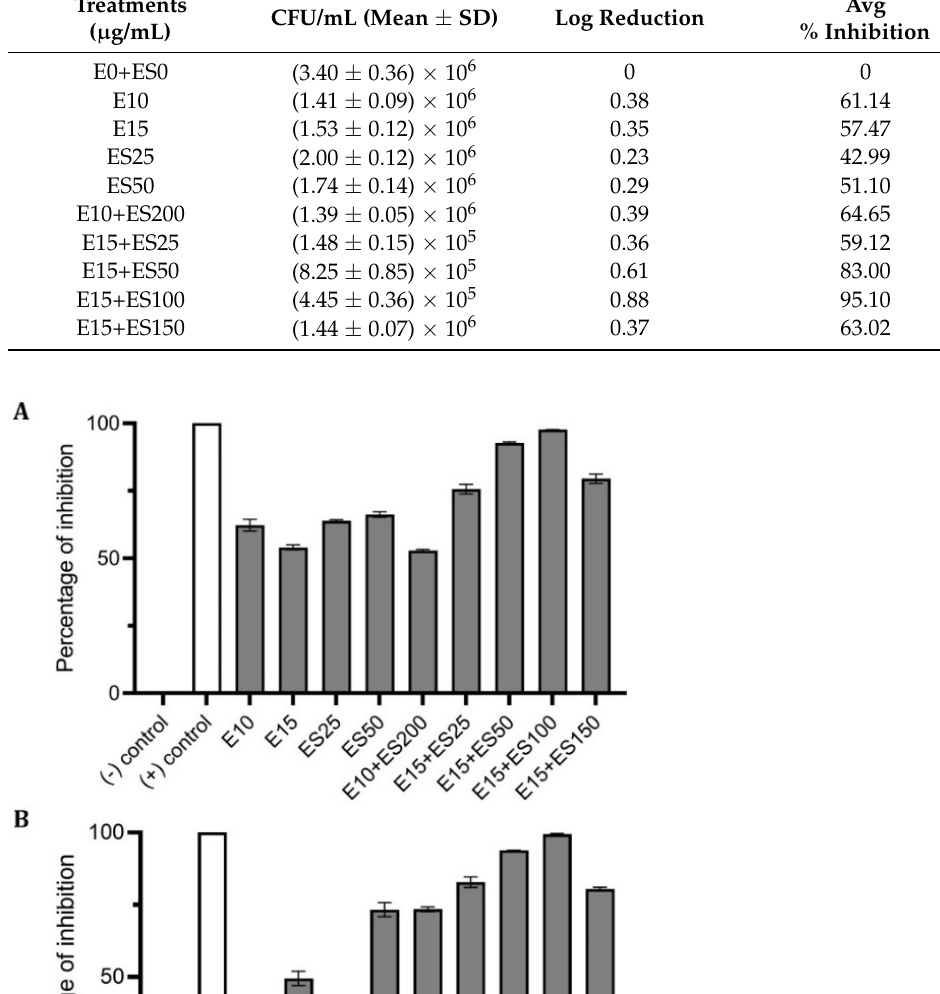
Table 3. Colony-forming units (CFU/mL) and respective log reduction and percentage of inhibition for different treatments on biofilm formation in P. aeruginosa . E: erythromycin; ES: EGCG-S. Treatments